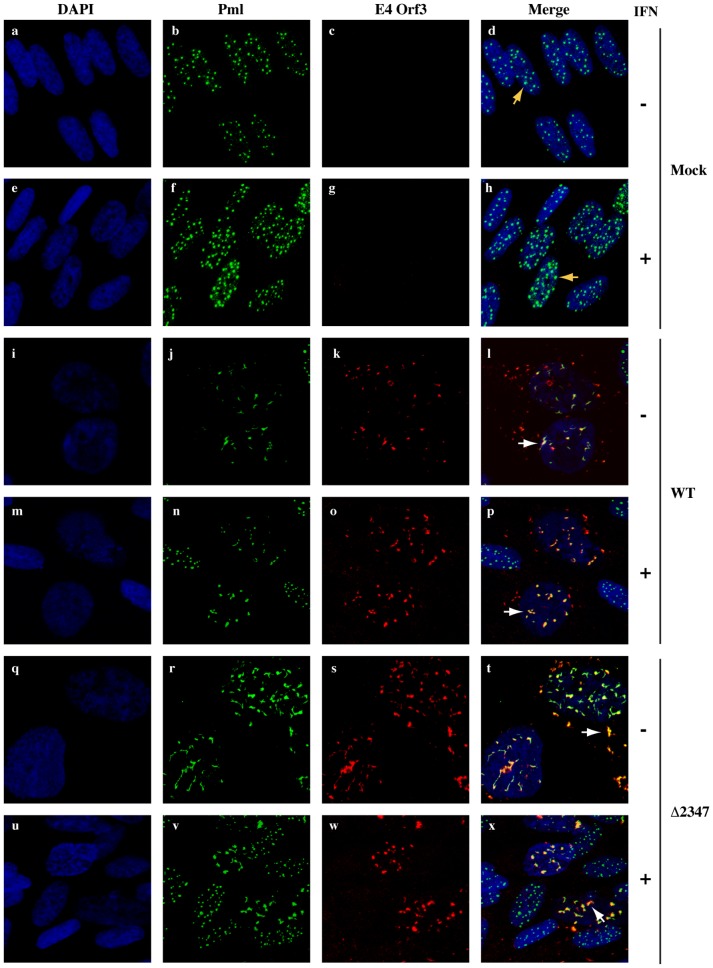
Reorganization of cellular PML proteins in AdEasyE1 and AdEasyE1Δ2347-infected, IFN-treated and untreated HFFs.HFFs grown on coverslips were IFN treated (+) or untreated (−) and infected with 30 p.f.u./cell AdEasyE1 (WT) (panels i–p) or AdEasyE1Δ2347 (Δ2347) (panels q–x), or mock infected (M) (panels a–h), and stained for the cellular Pml (green) and the adenovirus E4 Orf3 (red) proteins as described in Materials and Methods. DNA was DAPI stained (blue) and cells examined by confocal microscopy. Z-stack projections of representative fields are shown. Spherical Pml-bodies and track-like structures containing both the Pml and E4 Orf3 proteins are indicated by yellow and white arrows, respectively.